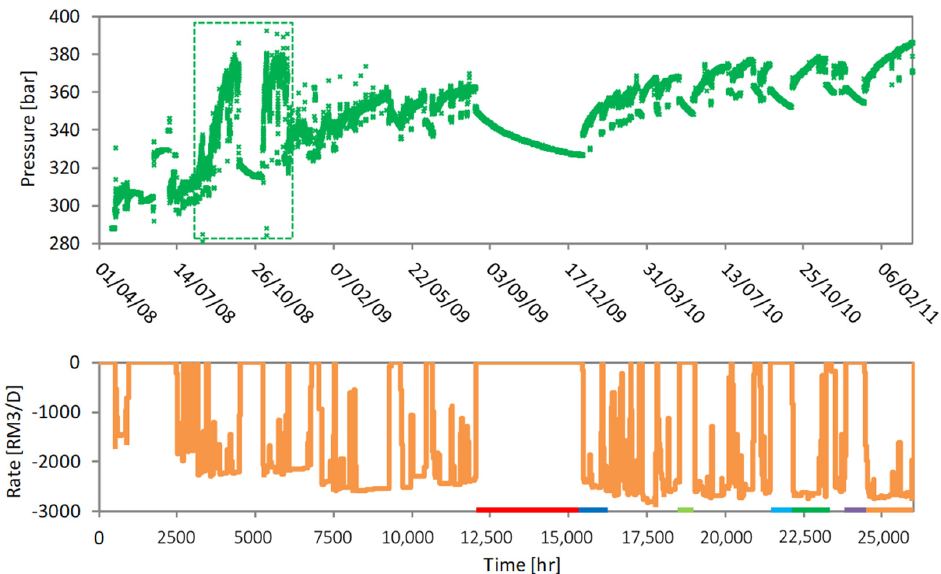
Figure 1. History of CO 2 injection into the Tubåen formation of the Snøhvit field containing many injections and shut-in periods [27]. The area highlighted by the square indicates period of well in- jectivity losses with following treatment to recover the injectivity.